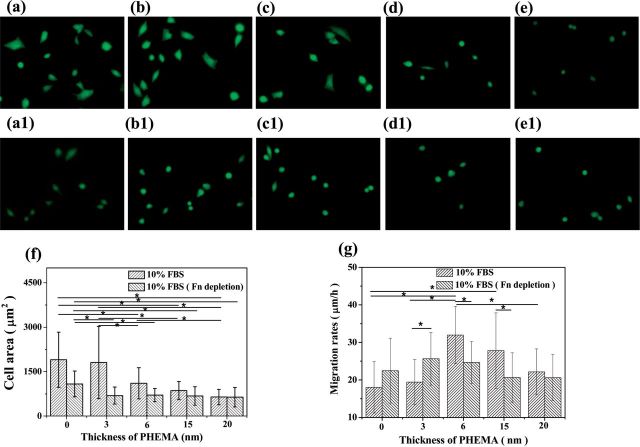
Images of VSMCs adhered on PHEMA brushes with thicknesses of 0, 3, 6, 15, 20 nm in (a–e) 10% FBS medium and (a1–e1) 10% Fn-depleted FBS medium, respectively. (f) Spreading area and (g) migration rate of VSMCs on PHEMA brushes with normal culture medium (10% FBS) and Fn-depleted medium, respectively. Asterisk indicates significant difference at P < 0.05.